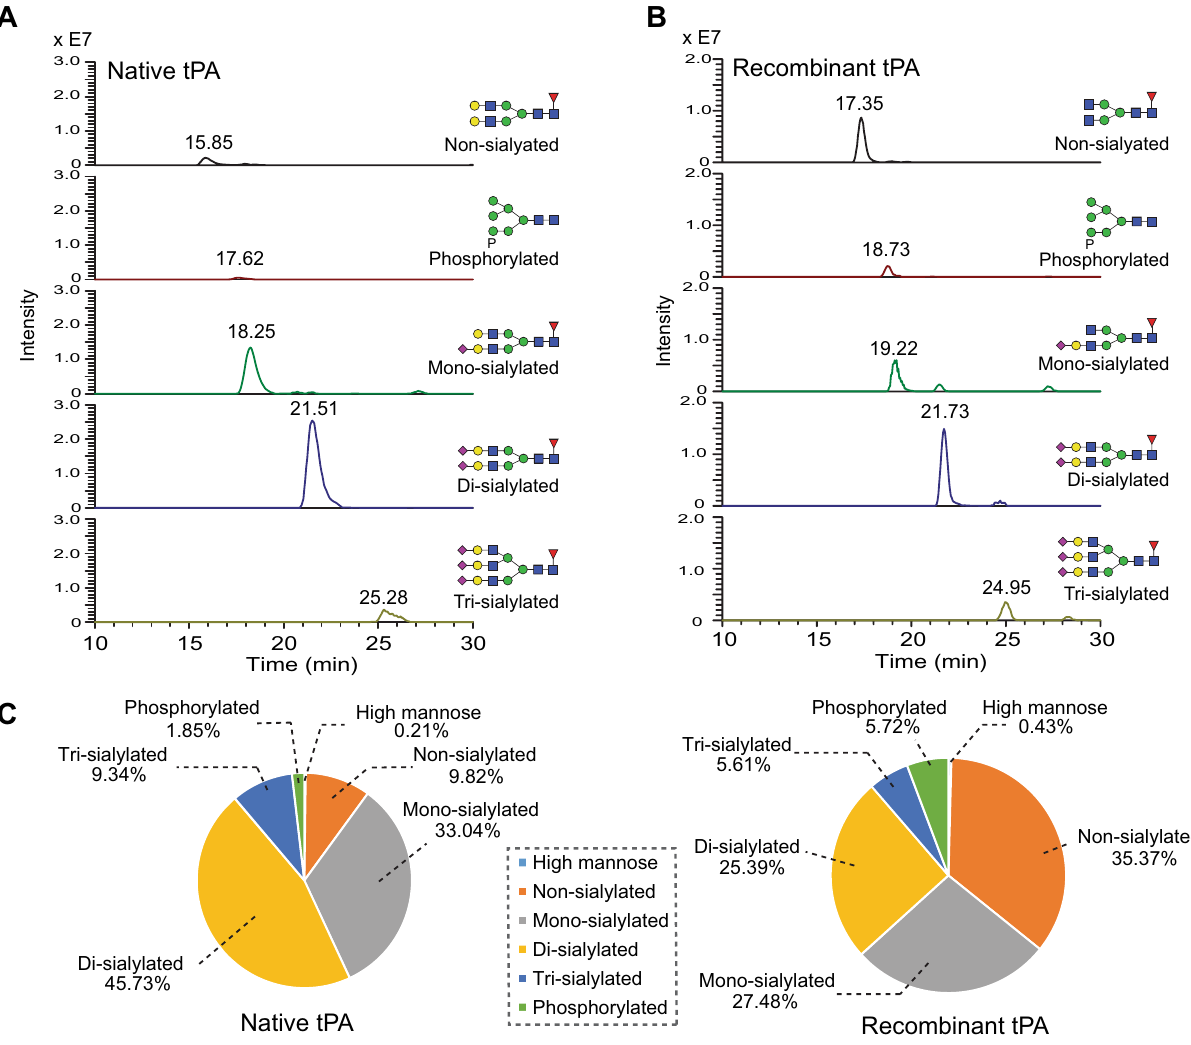
Figure 7. Glycopeptide profiles at N448 from native or recombinant tPA. Native or recombinant tPA glycopeptides obtained from trypsin/endoproteinase Glu C digestion were analyzed by reversed-phase (C18) LC–MS/MS. ( A , B ) Extracted ion chromatograms presenting the presence of the indicated peptide glycoform for ( A ) native and ( B ) recombinant tPA. ( C ) Pie charts present the relative abundance of each class of glycopeptide glycoform at the N448